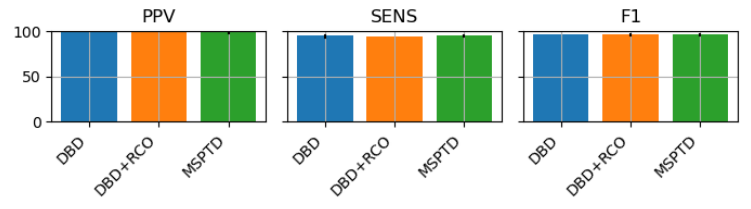
Figure 5. Performances of the heartbeat detection algorithms on the PPG-DALIA dataset.